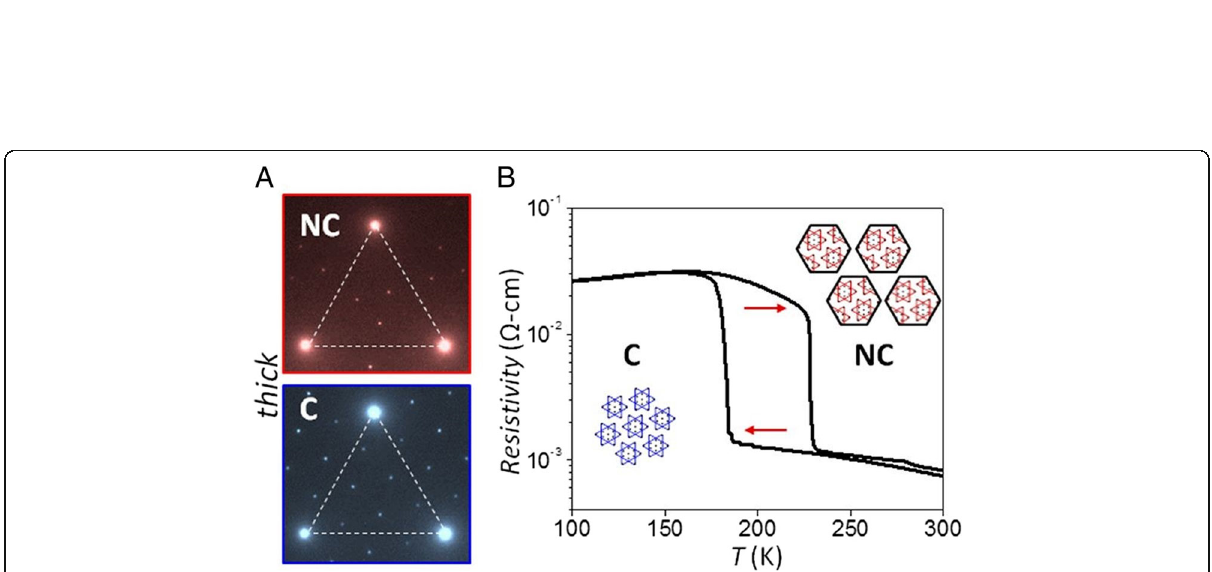
Fig. 4 Nearly commensurate to commensurate phase transition in 1 T-TaS2 and CDW suppression by oxidation in thin flakes. a TEM diffraction images of 1 T-TaS2 at 295 K (red, NC phase) and 100 K (blue, c phase). Weaker peaks are due to CDW distortion. b Resistivity vs. temperature of bulk 1 T-TaS2 crystal around the first-order, NC-C transition. Reprinted from Tsen et al. (2015) (Proc. Natl. Acad. Sci. 112, 15,054 – 15,059) with National Academy of Sciences of Prospects of the United States of America ’ s